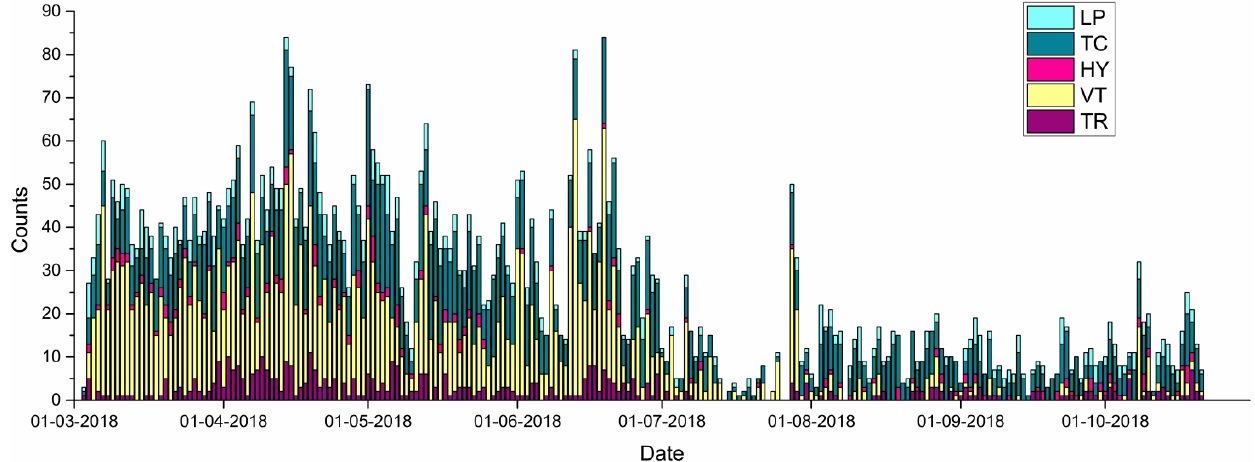
Figure 5. Temporal evolution in the production of events of the different classes for the Lascar volcano in the period from March to October